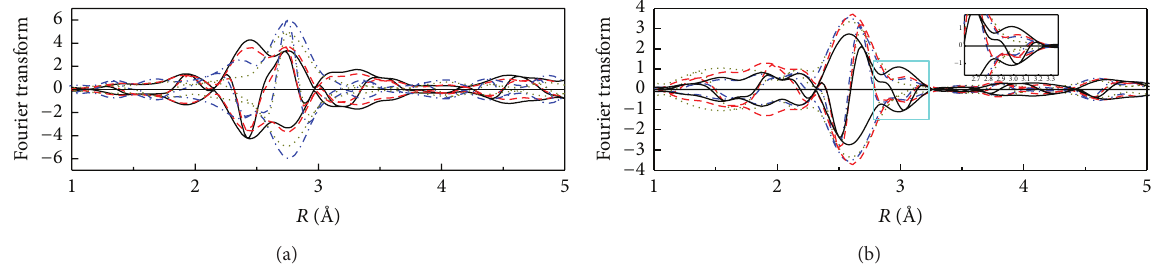
−1 , Pt-Pt phase and amplitude corrected) of −1 , Ru-Ru phase and amplitude corrected) of EXAFS data at Ru K edge